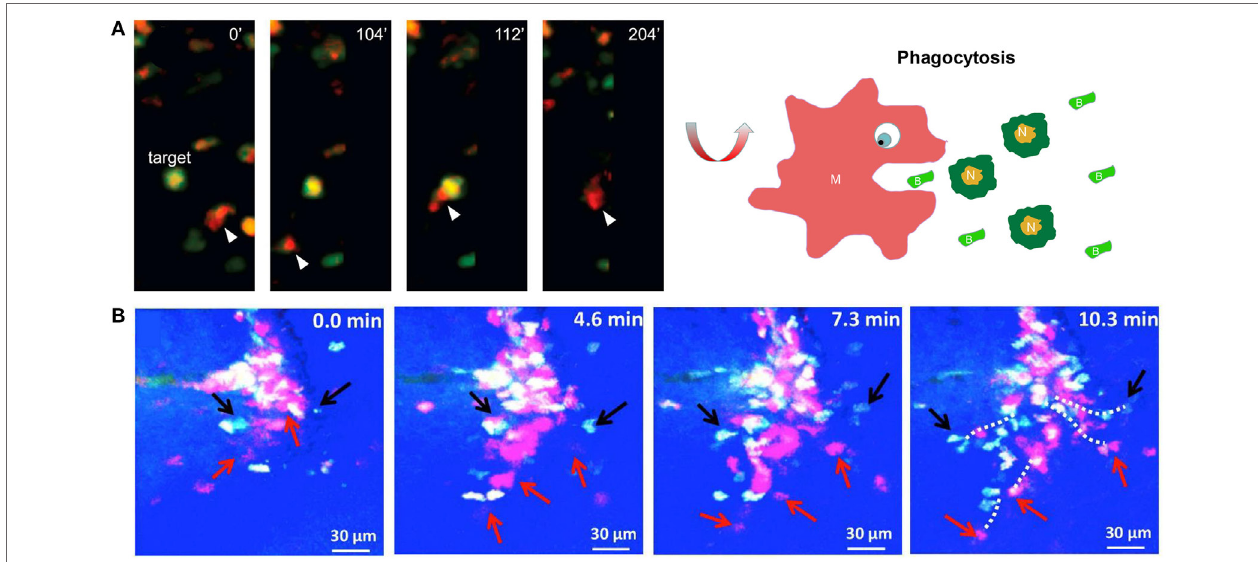
FiGURe 3 | Imaging macrophages in the context of wound healing. (a) Intravital imaging showed that mCherry-labeled macrophages engulfed green fluorescent protein-expressing necrotic/apoptotic neutrophils ( N ) at the wound site in transgenic Xenopus larva [reproduced under the terms of the CC BY 4.0 license, Copyright © 2015 Paredes et al. (83)]. (b) Time-lapse imaging showed that ECFP + monocytes and PE-labeled neutrophils concomitantly infiltrated the wound bed through microhemorrhages in the skin wound of mice [reproduced under the terms of the CC BY 4.0 license, Copyright © 2014 Rodero et al.]